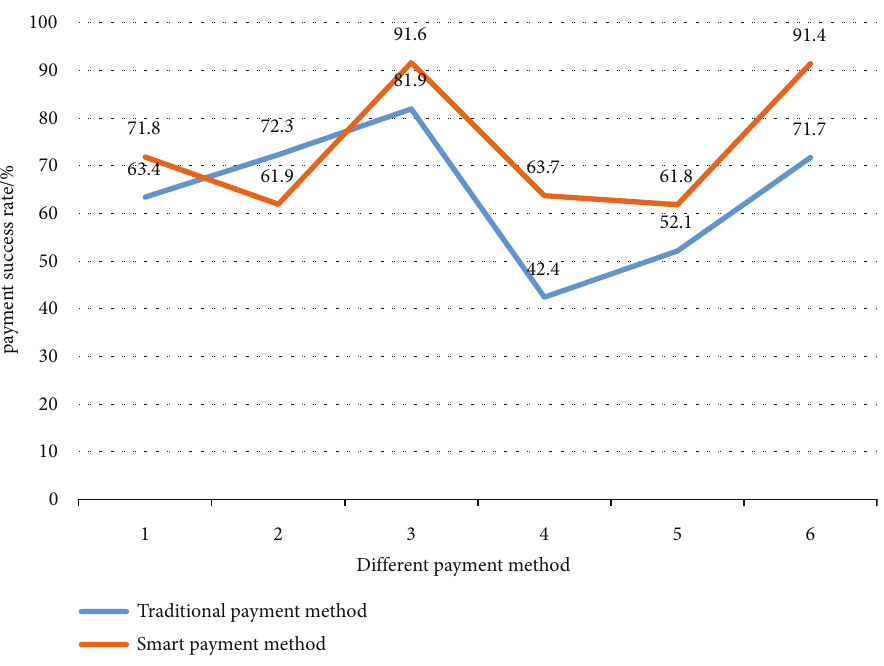
Figure 7: Payment success rate of two payment